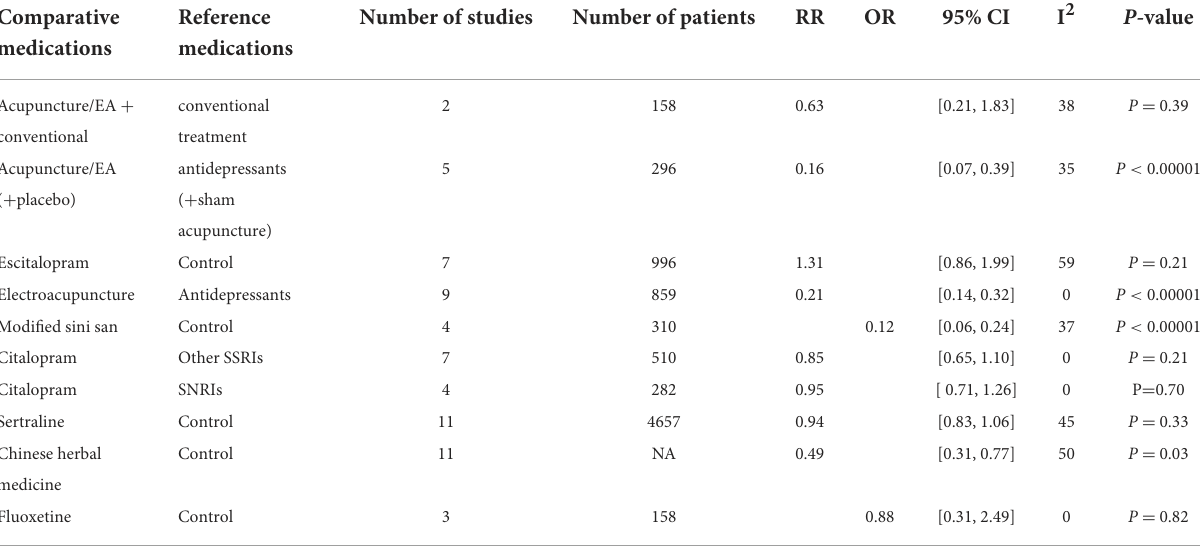
TABLE 5 Results of pairwise meta-analyses for adverse